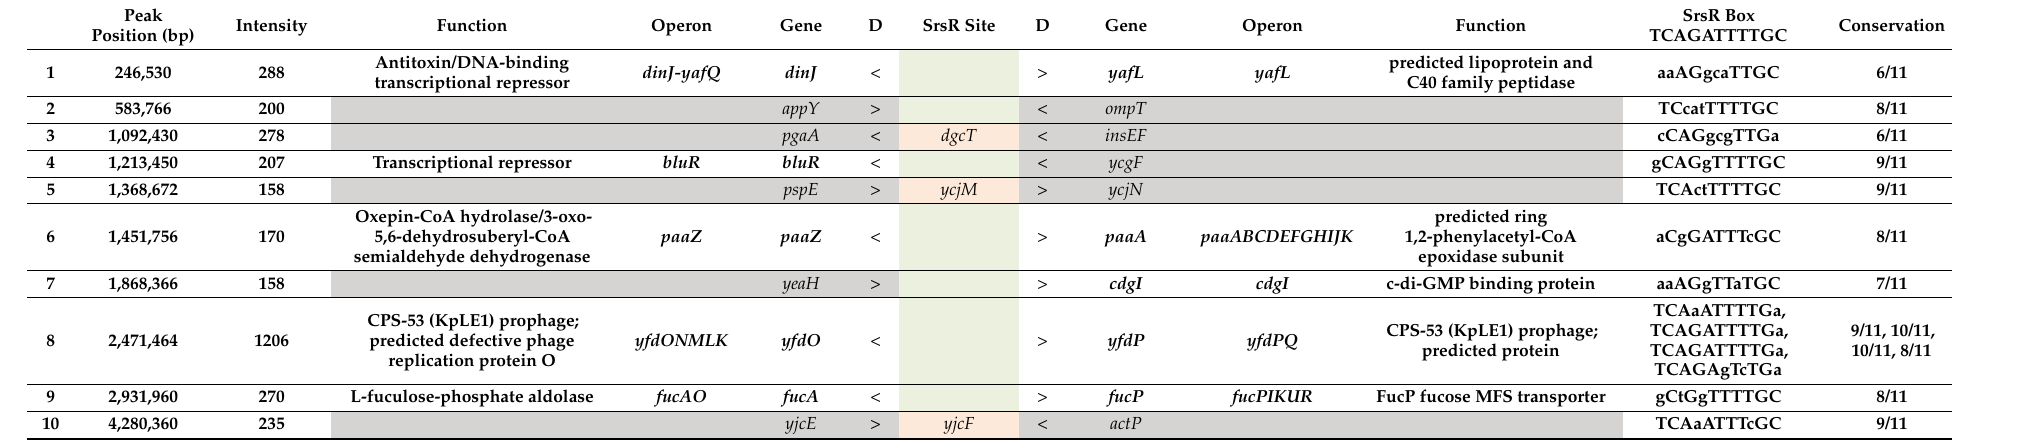
Table 1. SrsR-binding sites on the E.coli